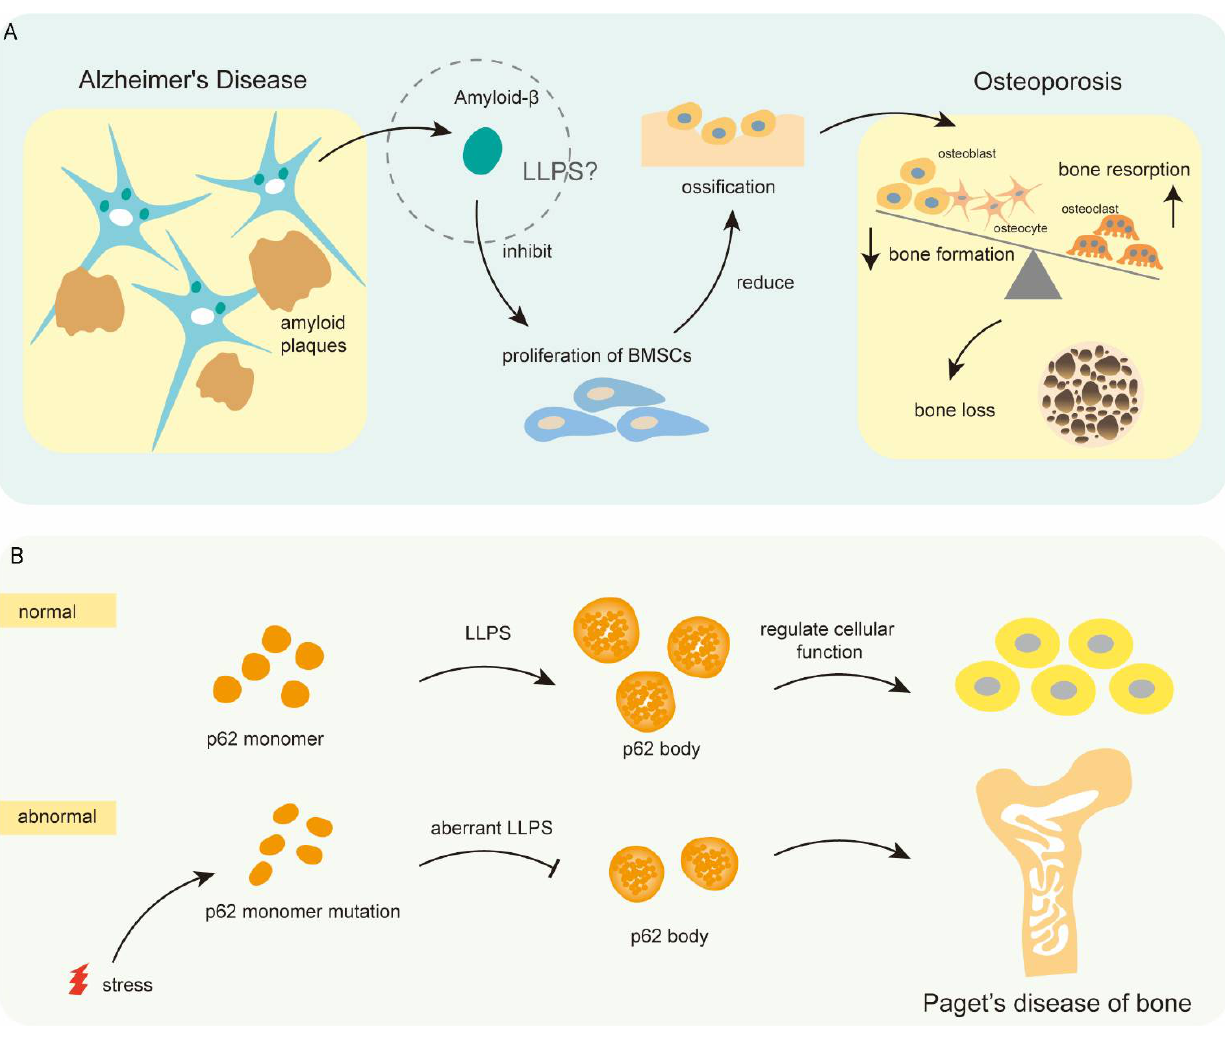
Figure 4. Roles of Amyloid proteins Aβ and p62 in metabolic bone diseases. ( A ) Aberrant aggregation of Amyloid-β through LLPS in the brain of AD patients can result in decreased ossification by inhibiting the proliferation of BMSCs. ( B ) Mutation of p62 led to its aberrant LLPS which further affected the formation of p62 body and resulted in pathology of Paget’s disease of bone.